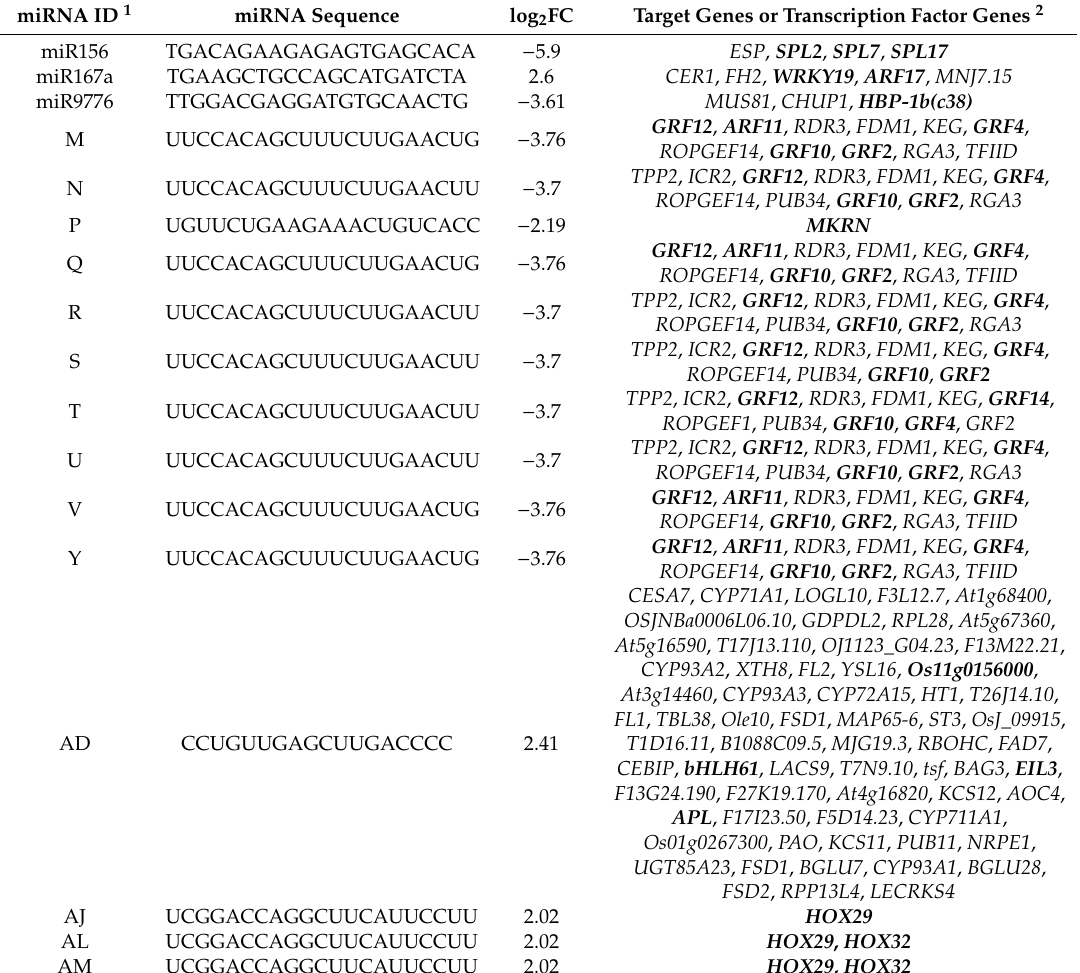
Table 2. Some key miRNAs and their targets identified in the integrative regulation